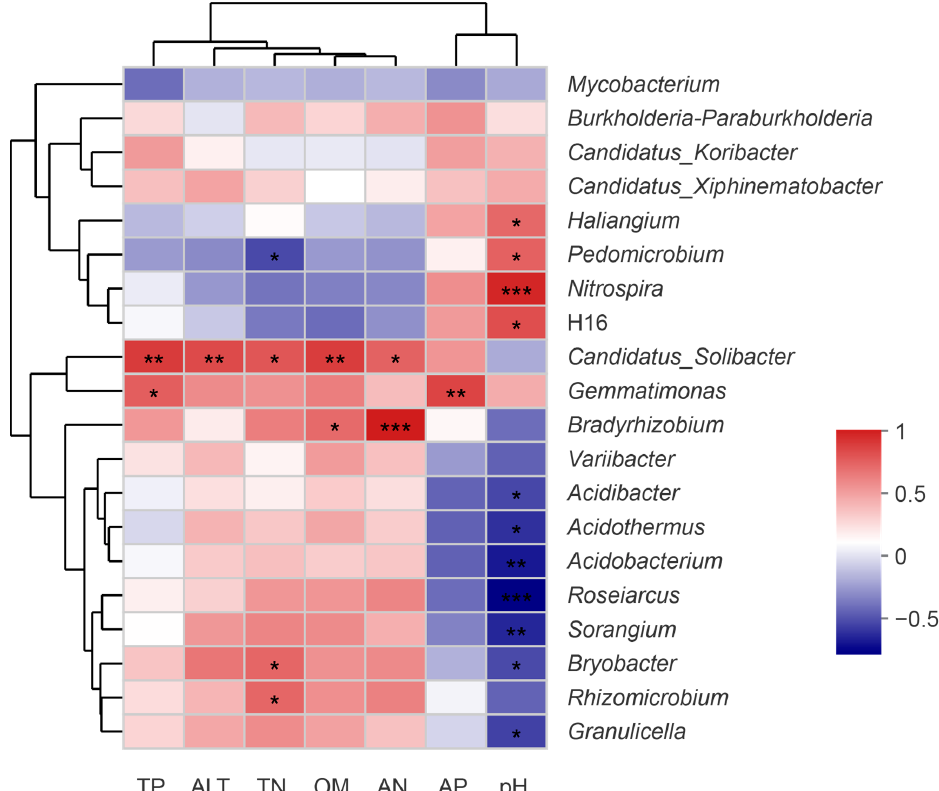
Figure 5. The Spearman correlation analysis between soil chemical properties, altitude and bacterial genus. Top 20 abundant bacterial genera are listed. * 0.01 < p ≤ 0.05; ** 0.001 < p ≤ 0.01; *** p ≤ 0.001. OM, organic matter content; AN, available N content; AP, available P content; TN, total N content; TP, total P content; ALT, altitude.